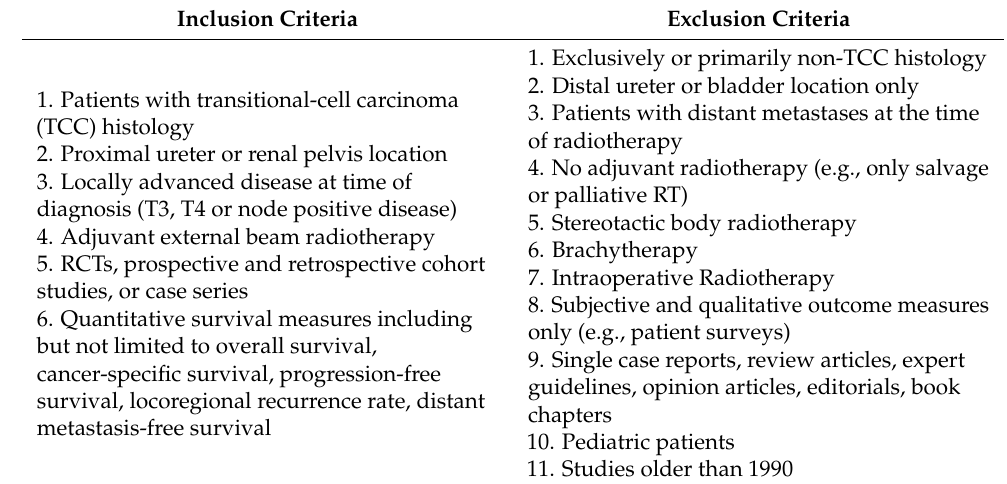
Table 1. Study inclusion and exclusion